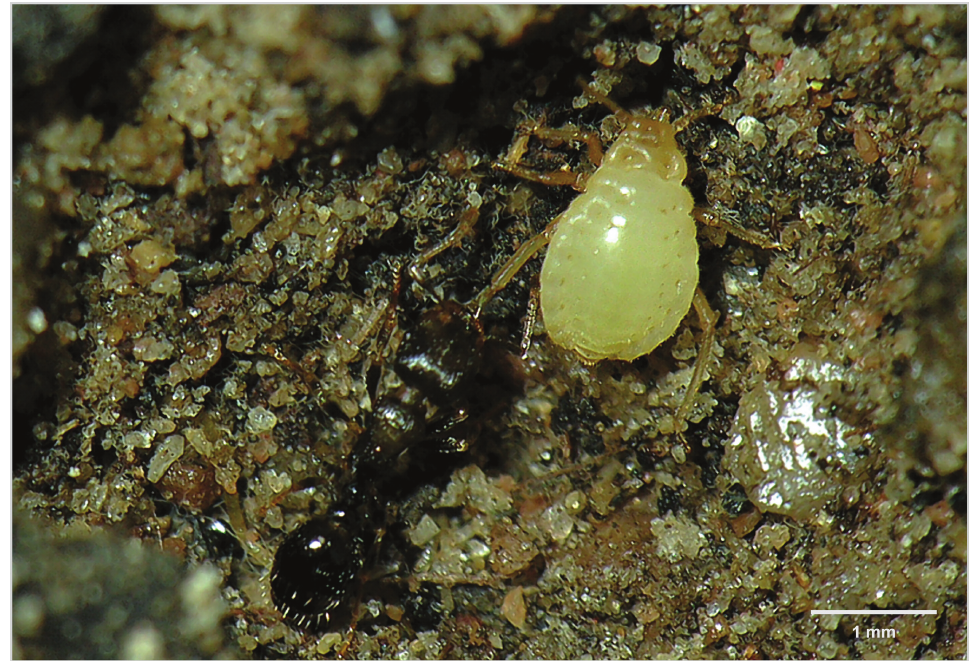
Fig. 31. Paracletus cimiciformi s von heyden, 1837. Aptera in nest of Tetramorium caespitum (linnaeus, 1758).